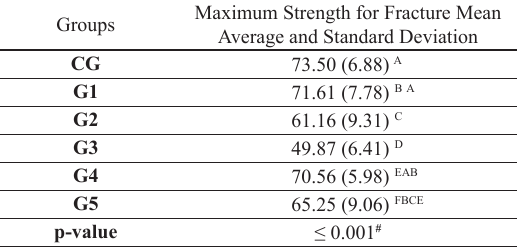
Table 3. Flexural Strength Test. (Strength in Newton).